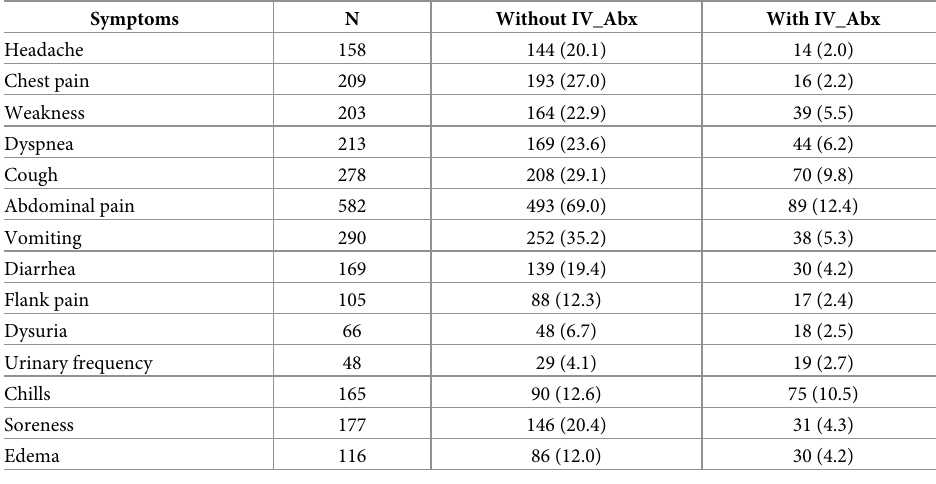
Table 4. Comparison of symptoms and use of intravenous antibiotics at the index